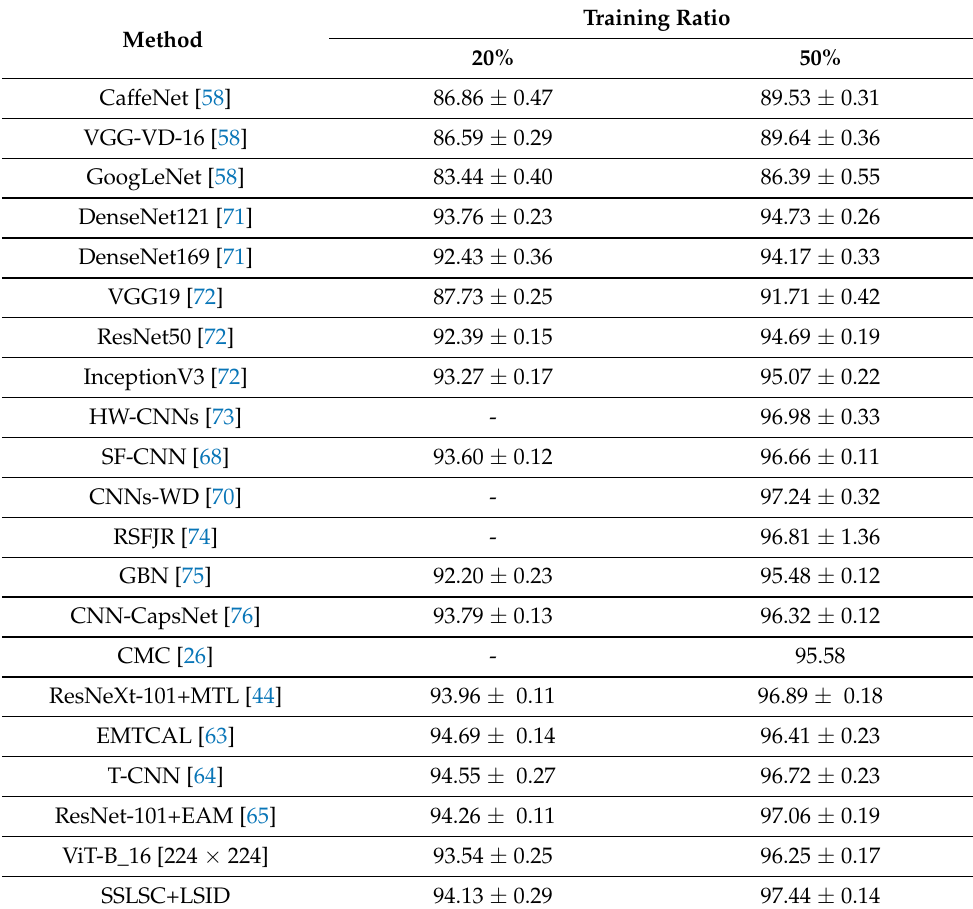
Table 3. OA (%) of twenty kinds of methods and our method under the training ratio of 20% and 50% on AID dataset.